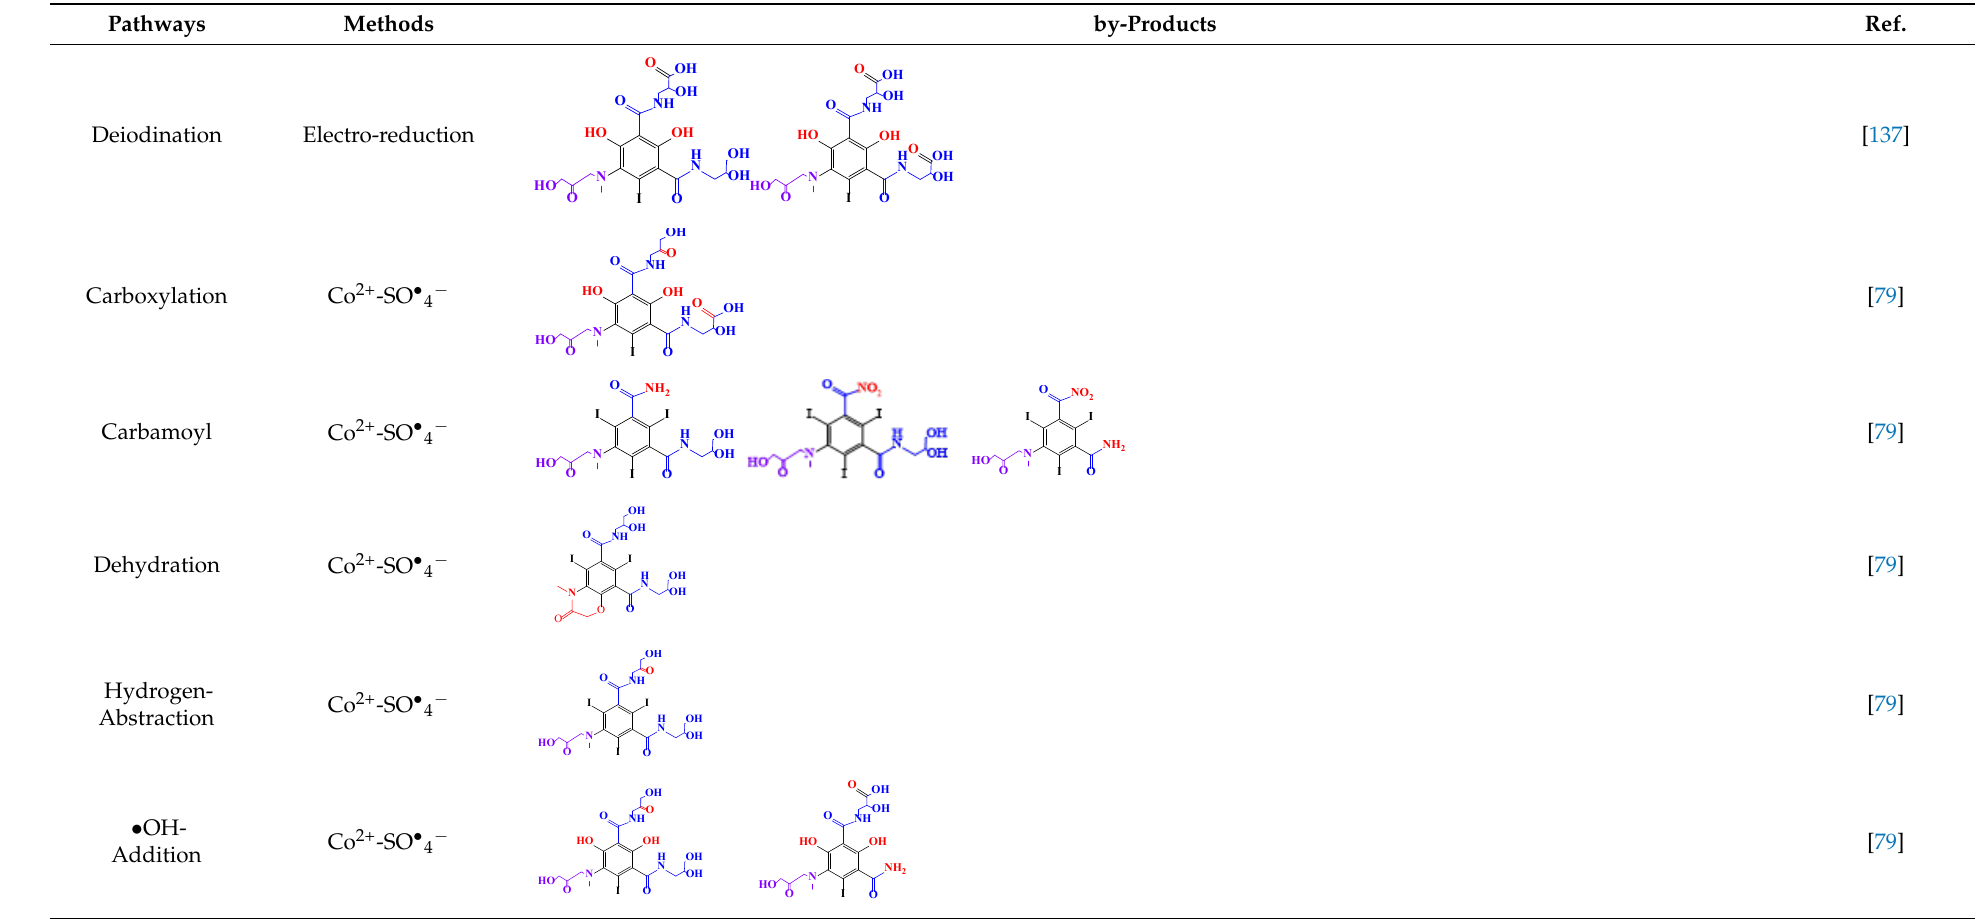
Table 7. Identified by-products of iomeprol in recent literature.